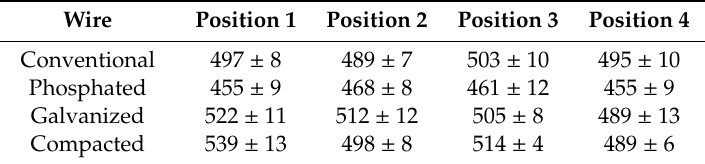
Table 3. Thickness of the galvanized layer in micrometers on the surface